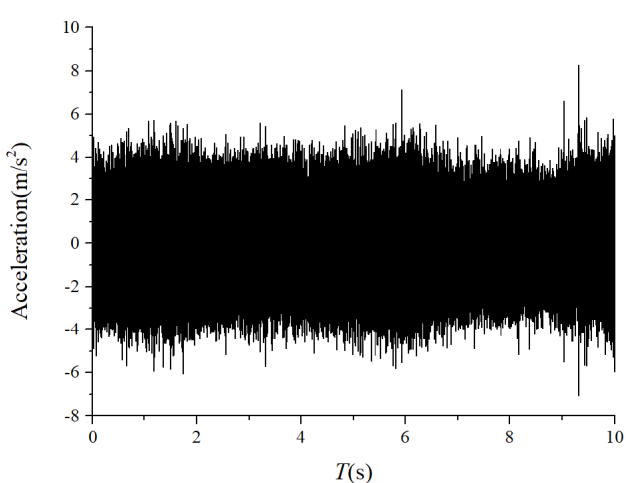
Figure 39. Acceleration waveform (severe friction).